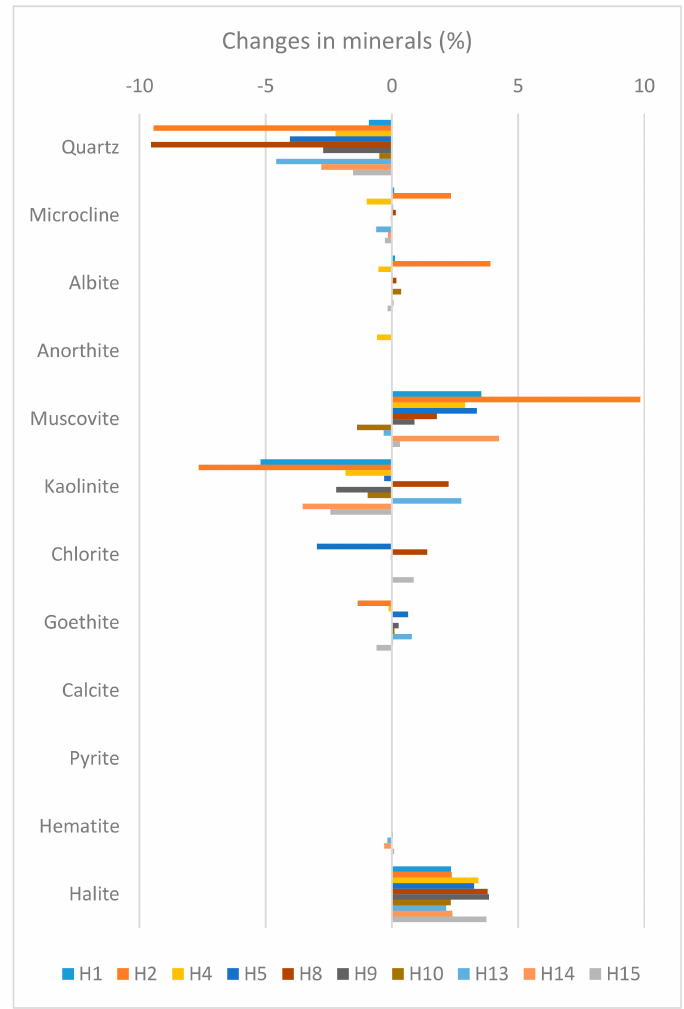
Figure 13. Changes in mineral content after exposure in